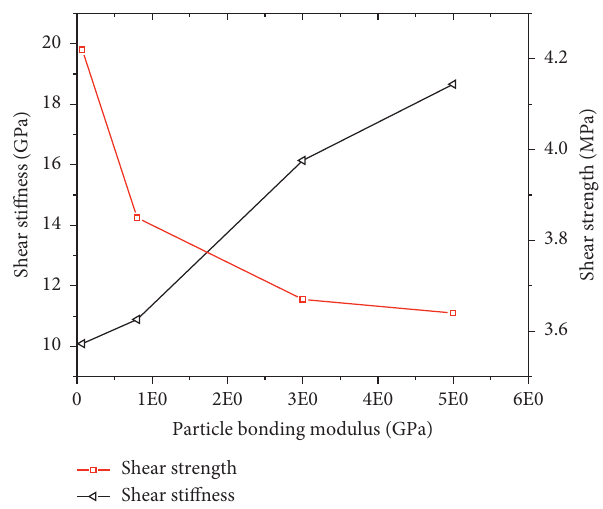
Figure 7: Relationship between parallel bonding modulus and shear stiffness and shear